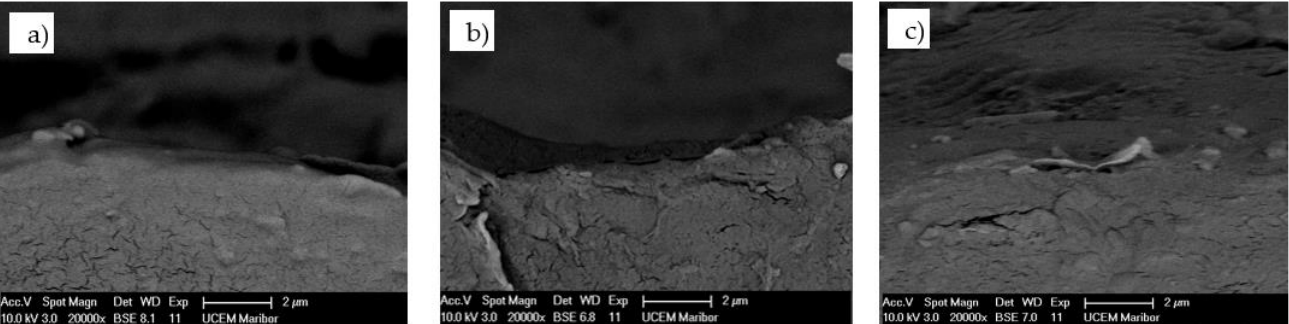
Figure 5. SEM micrograph of the coated surface of POM-gear: ( a ) Al-coating, ( b ) Cr-coating, ( c ) CrN coating.